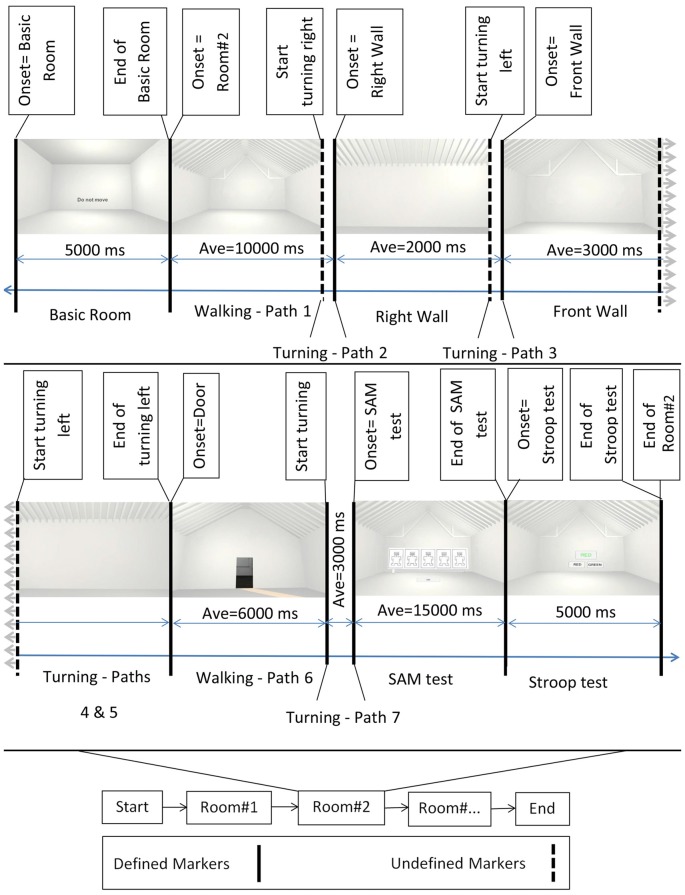
Block diagram of the experiment. Bottom middle: the onset of the different rooms. Top: example of rooms’ perspectives as participants perceived them while walking. First and then second row from left to right, after showing the Basic room for 5000 ms with a “Do Not Move” sign, the trial started and participants walked inside the virtual room. They then turned 90 degrees to their right and faced the right wall. Subsequently they turned 90 degrees to their left and faced the front wall, followed by an additional turn of 90 degrees to their left to face the left wall. After one additional turn of 90 degrees to their left, participants faced the entrance door. Then, participants walked back to the starting point (entrance door) and turned 180 degrees to face the room. At the end of each trial, the virtual self-assessment manikin (SAM) test and the Stroop test were shown. Defined markers describe events in the experimental protocol that were controlled and appeared at predefined time points during the experiment. These included, e.g., the onset of the basic room, the onset of the SAM test, etc. Undefined markers denote events that were not determined by the experimental protocol, i.e., the time point of some of the turnings depended on the individual preferred movement speed and viewing time. Sample room was created from Banaei et al. (2017).